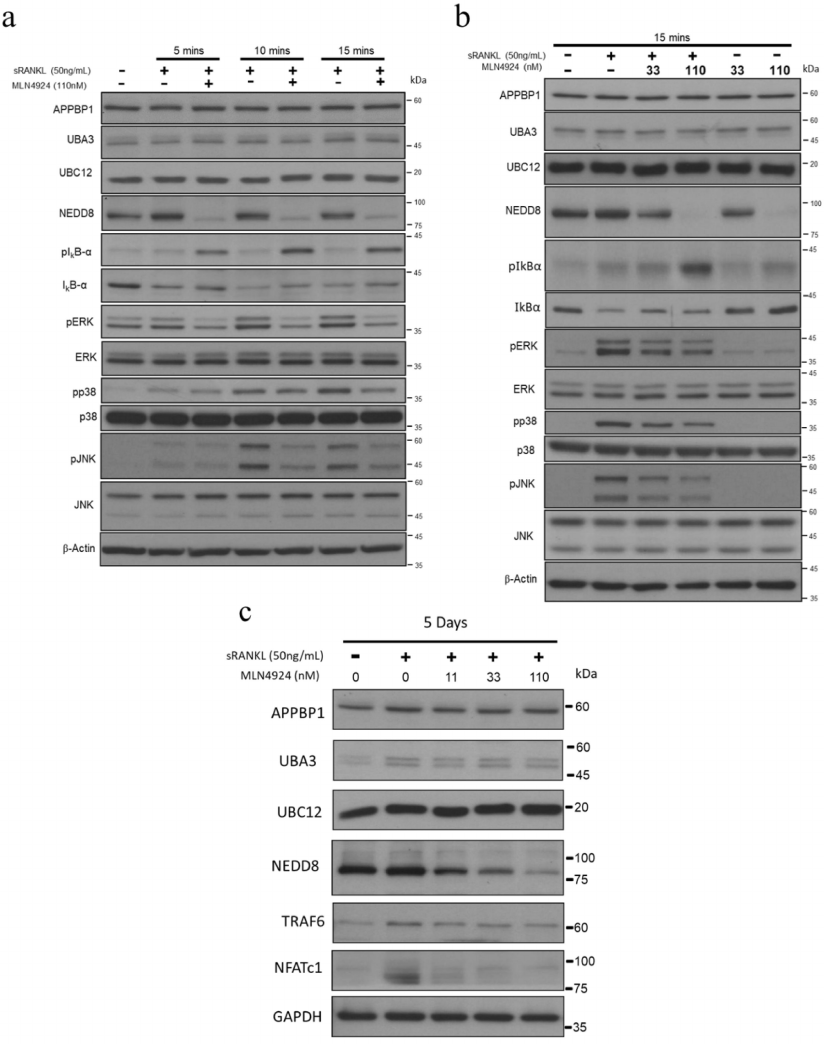
Figure 4. Effect of MLN4924 on neddylation and sRANKL-stimulated signaling pathway in RAW 264.7 cells ( a ) RAW 264.7 cell were pretreated with 110 nM MLN4924 for 30 min, followed by treatment with sRANKL (50 ng/mL) at 5, 10, and 15 min, or ( b ) 33 and 110 nM MLN4924 for 30 min, followed by treatment with sRANKL (50 ng/mL) at 15 min. Cell lysates were collected and subjected to immunoblotting analysis for neddylation (APPBP1, UBA3, UBC12, and NEDD8) and sRANKL-induced pathway (phosphorylation of I k B- α (pI k B- α ), ERK (pERK), P38 (pP38), and JNK (pJNK)). ( c ) RAW 264.7 cells were cotreated with sRANKL (50 ng/mL) and various concentrations of MLN4924 (11–110 nM) for 5 days. Cell lysates were collected and subjected to Western blotting with neddylation-related proteins (APPBP1, UBA3, UBC12, and NEDD8) and specific antibodies for sRANKL-induced proteins (TRAF6 and